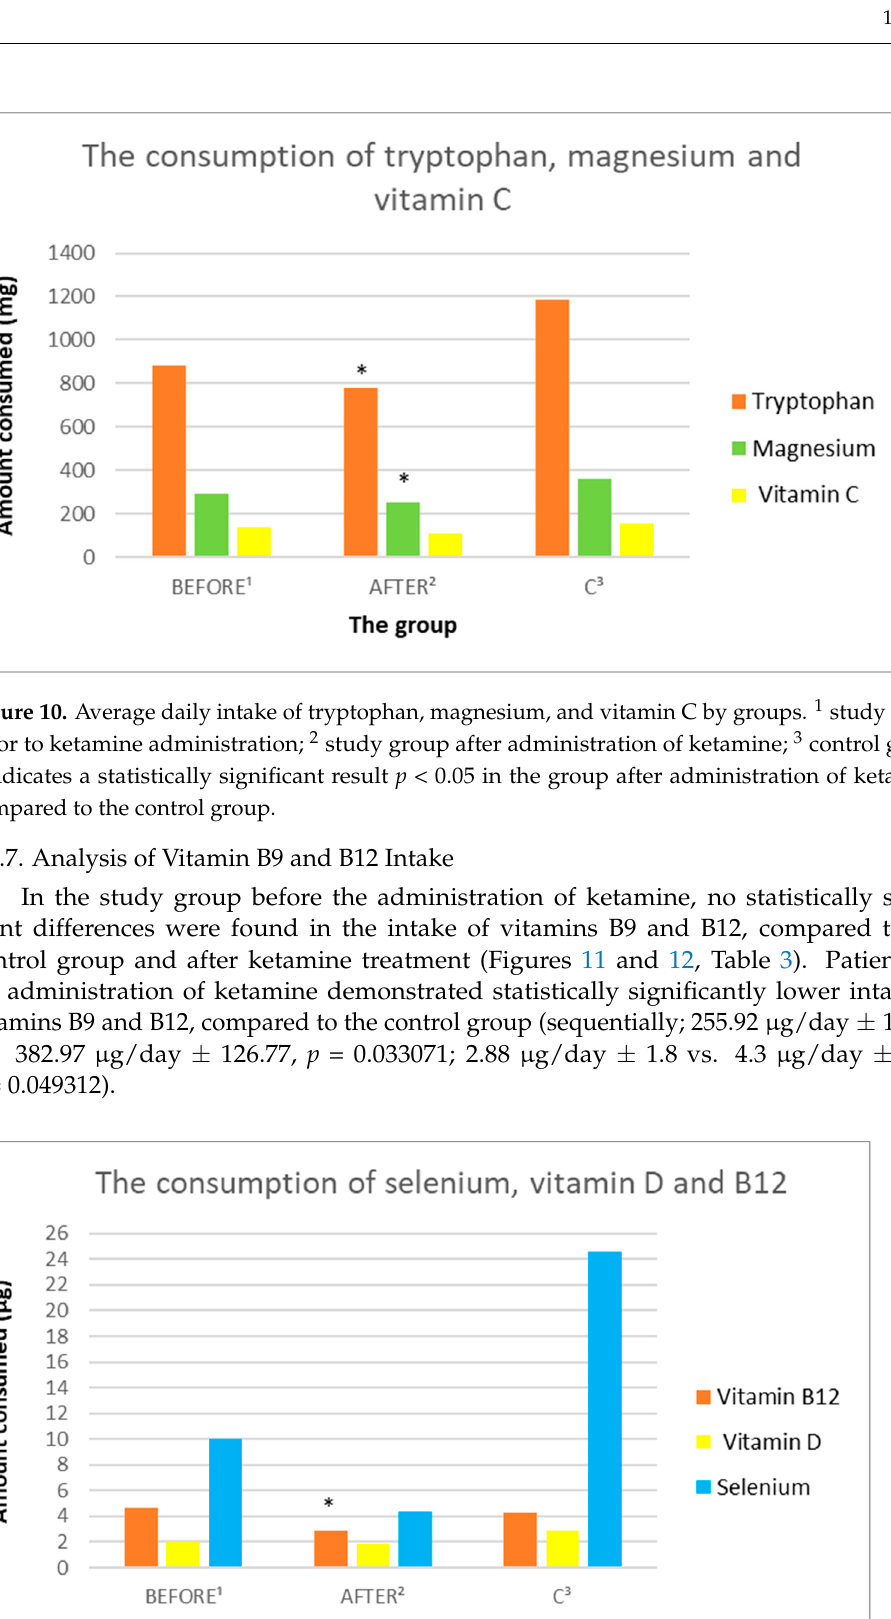
Figure 12. Average daily zinc, iron, vitamin E, B9, and A intake by groups.¹ study group prior to ketamine administration; ² study group after administration of ketamine; ³ control group; ^ means a statistically significant result p < 0.05 for the pre-ketamine group, compared to the control group;